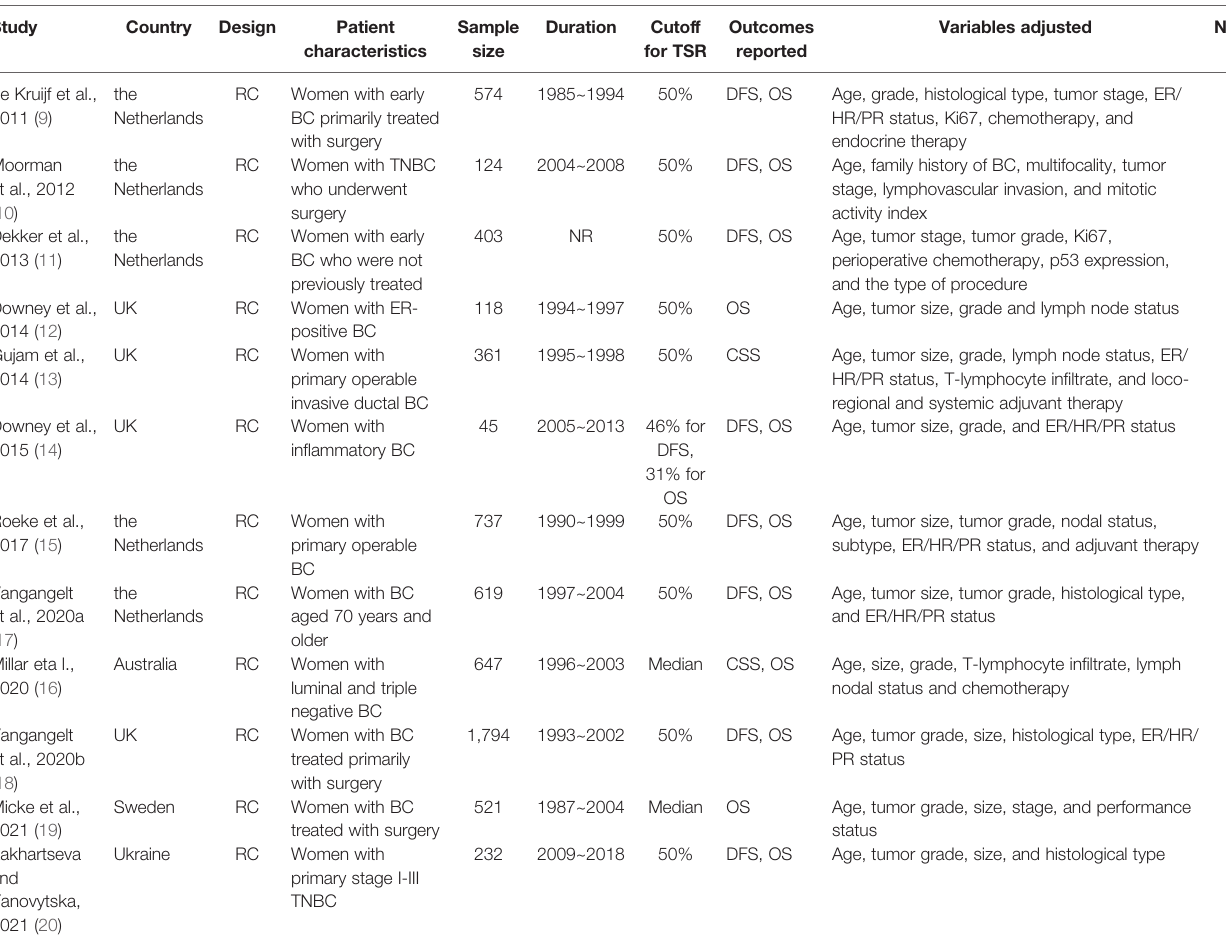
TABLE 1 | Characteristics of the included cohort